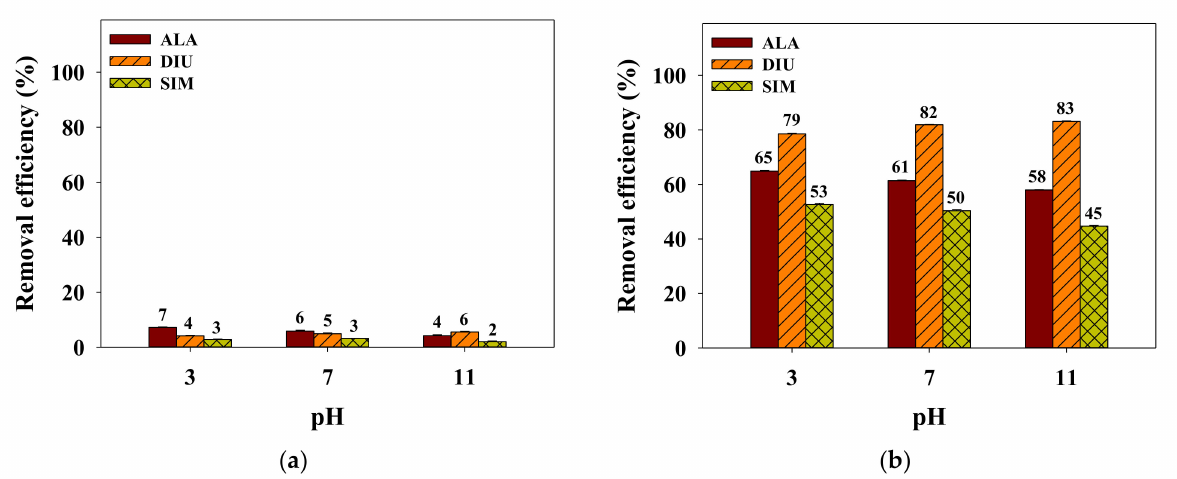
Figure 7. The effects of the solution pH on the removal of the herbicides by ( a ) GCRB and ( b ) GCRB-N (agitation speed = 150 rpm, contact period = 24 h, absorbent dosage = 50 mg/L, initial concentration of each herbicide = 10 µ M, and temperature = 25 °C).